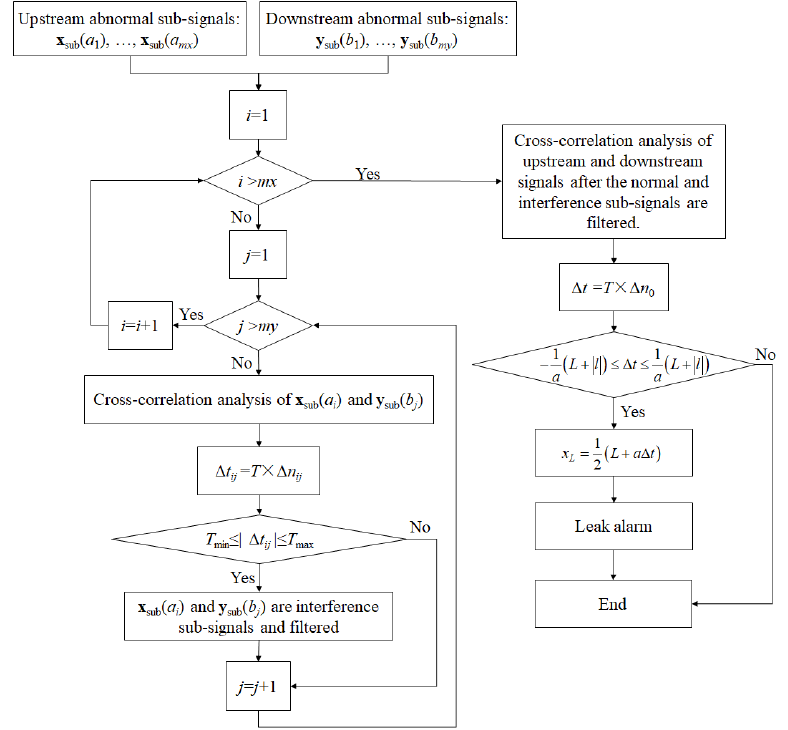
Figure 16. Flow chart of the leak location method based on filtering operation sub-signals.